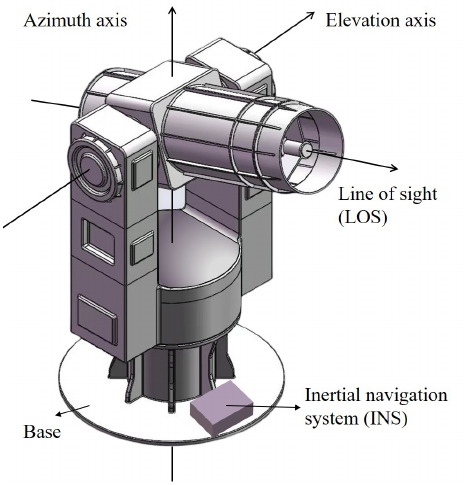
Figure 1. Gimbal arrangement of the electro-optical